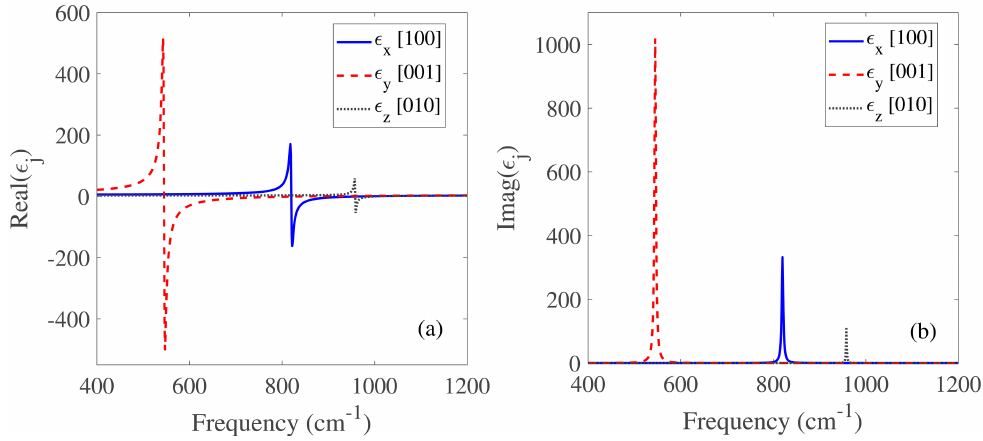
Figure 2. Real ( a ) and imaginary ( b ) parts of the dielectric function for α - MoO 3